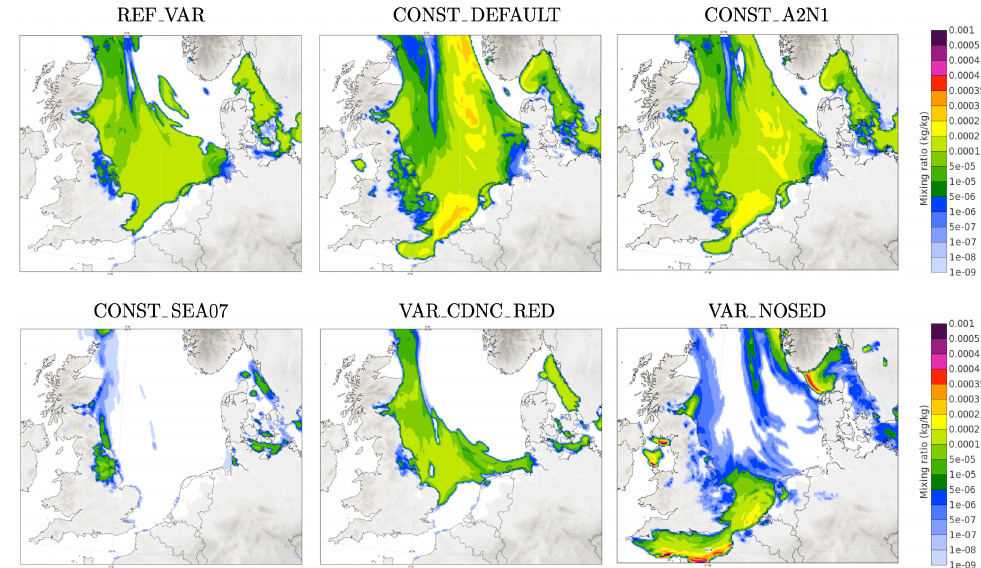
Figure 10. North Sea. liquid–water mixing ratio (kg/kg) at the lowest model level, +047 h (24 March 2012 at 11